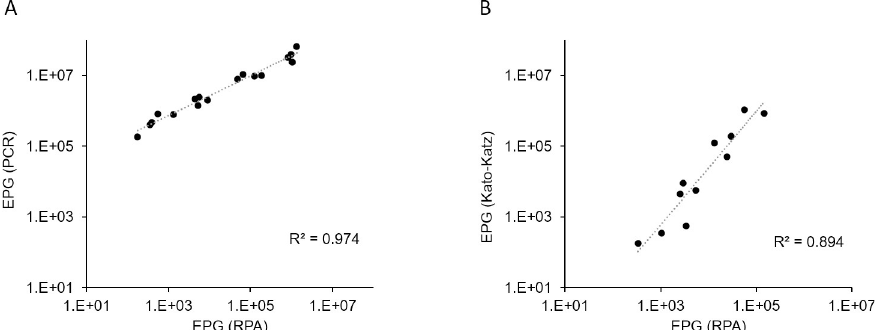
Fig 4. Correlation of the number of A . lumbricoides eggs per gram (EPG) of stool derived from either Dx4STH-1 and real-time PCR (A) or from Dx4STH-1 and Kato-Katz method (B). Data sets of each assay were generated using the same set of A . lumbricoides -positive stool samples. For Dx4STH and real-time PCR, EPG was calculated using the standard curve generated from the analysis of the egg-spiked stools. Pearson correlation was used to assess an association between the EPG values derived from the three methods, as well as the RPA T t and PCR C q values and EPG values derived by the Kato–Katz